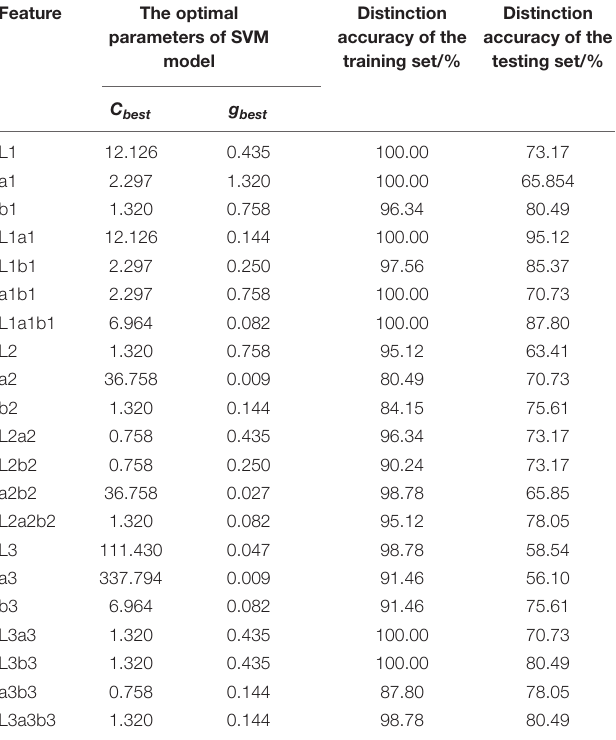
TABLE 4 | Distinction results of the SVM models based on the LBP histogram features of the gray images of the three components in the L*a*b* color space of the segmented lesion images.